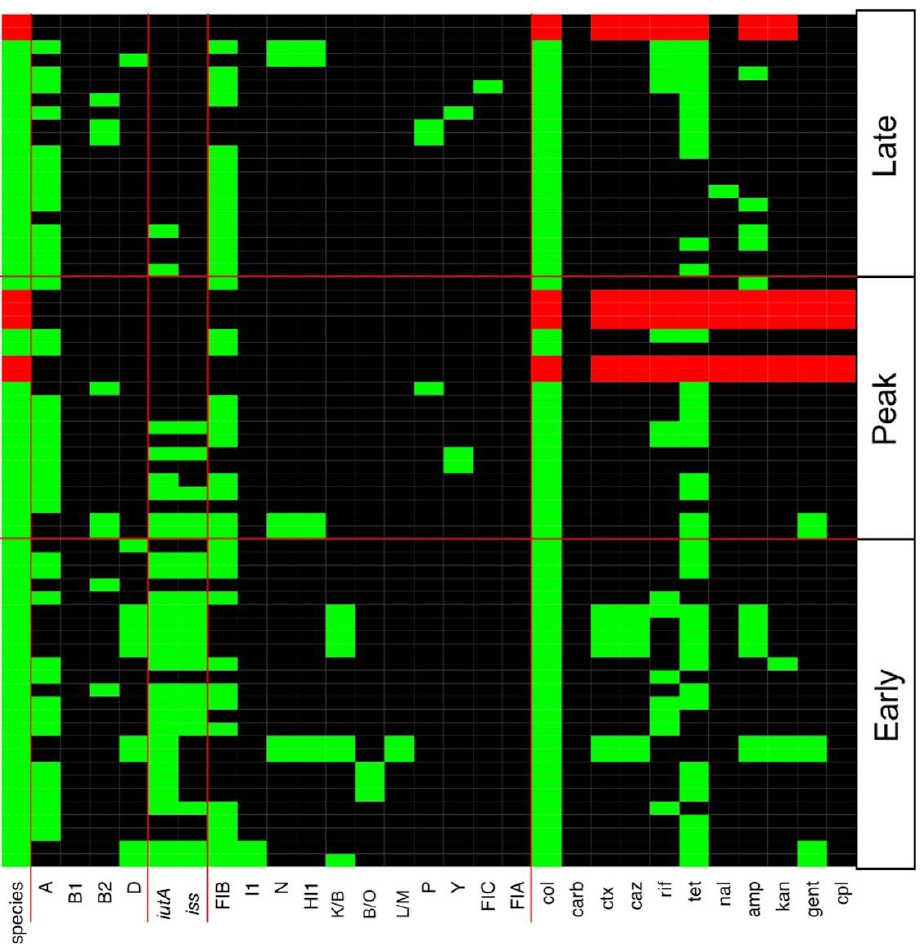
Figure 3. Heatmap of genes and phenotypes detected in conventional cage antibiotic resistant isolates. All positive E. coli results are shown in the heatmap as green. All positive Acinetobacter spp. are shown as red. Negative results are shown in black in the heatmap. Col, colistin; carb, carbapenem; ctx, cefotaxime; caz, ceftazidime; rif, rifampicin; tet, tetracycline; nal, nalidixic acid; amp, ampicillin; kan, kanamycin; gent, gentamicin; cpl, chloramphenicol.